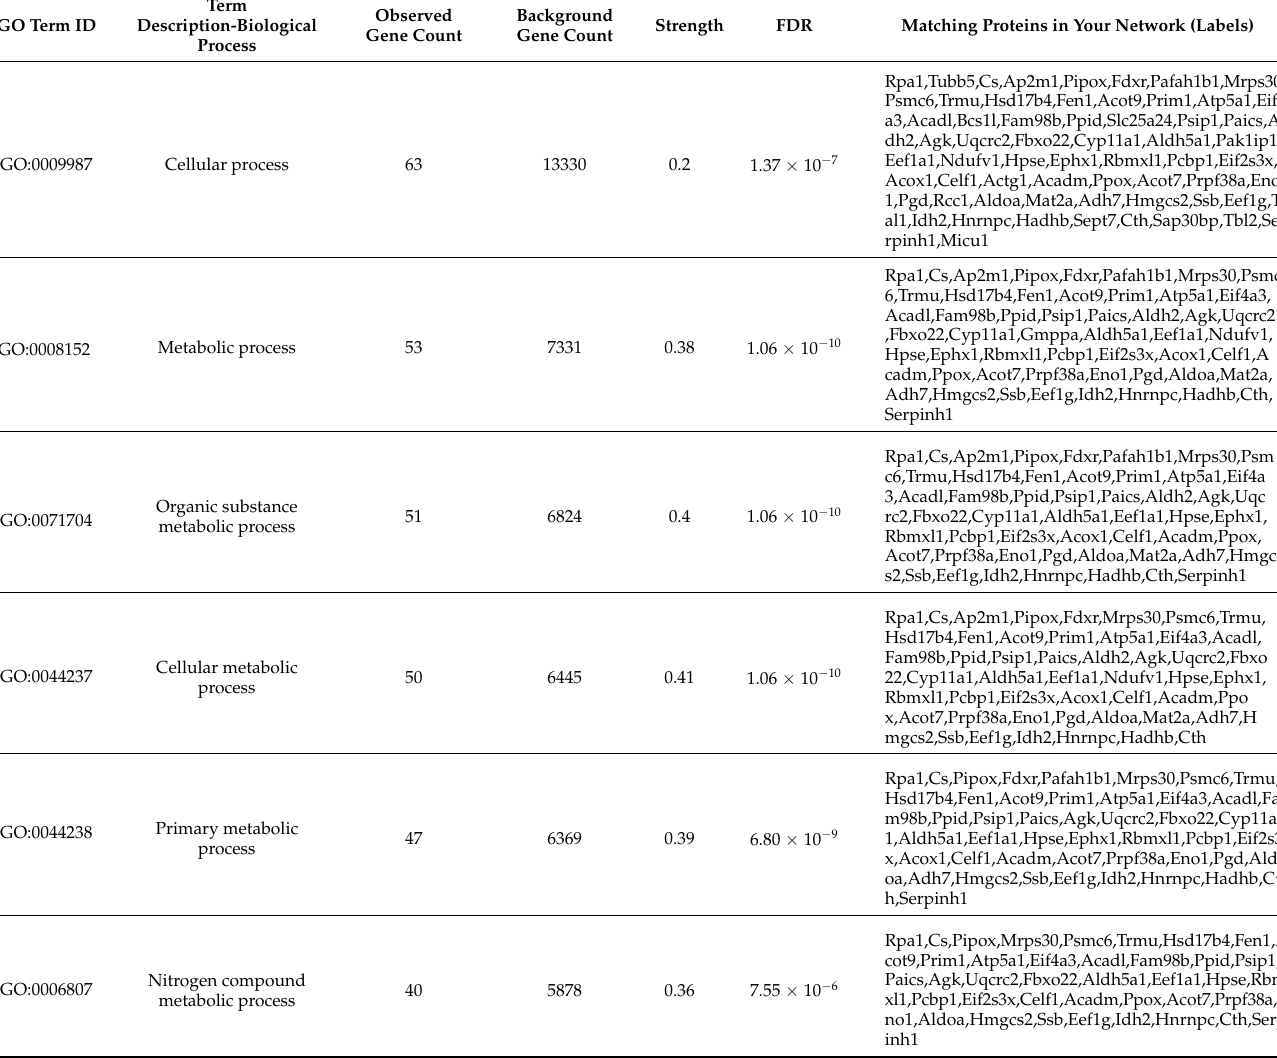
Protein content in the spots corresponding to Sample 2 (yellow circles in Figure 3) was determined by LC-MS/MS. Results were then analyzed using Scaffold software with protein threshold 99%, minimum unique peptide 2 and peptide threshold 95%. ( A ) The proteins present in Sample 2 were further analyzed using the String software to identify the interactions and associations between the various proteins and their implications in biological processes (listed in Table 4). The lines between the nodes correspond to the type/strength of an interaction according to annotations in String. The colors of the nodes refer to the following biological processes: green = gene expres- sion, red = lipid metabolic process, purple = nucleobase-containing compound metabolic process, yellow = mitochondrial transport. ( B ) OriginPro Version 2021 software was used to generate a Venn diagram identifying the protein present in each condition, as indicated. The proteins are listed in Table 5. ( C ) Putative differentially regulated proteins in each condition (as indicated) are shown as a heatmap generated using the OriginPro Version 2021 software. The protein names and whether they are up/downregulated after a treatment are indicated on the right of the heatmap. A relative intensity scale is shown on the left. Proteins that were below the detection level are represented by a gray rectangle. Table 5. Biological processes associated with proteins present in Sample